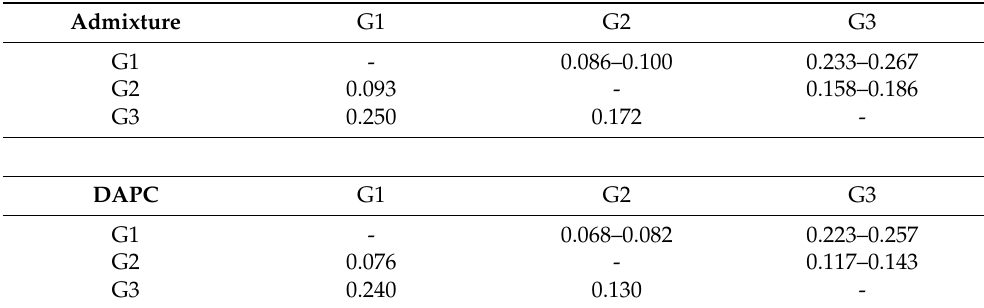
Table 2. Pairwise genetic differentiation (F ST ) among the three inferred genetic clusters ( K = 3) of C. pubescens using 1462 unlinked biallelic SNPs. F ST values are given below the diagonal. Lower and upper limits of 95% confidence intervals are given above the diagonal. G, genetic cluster/group.